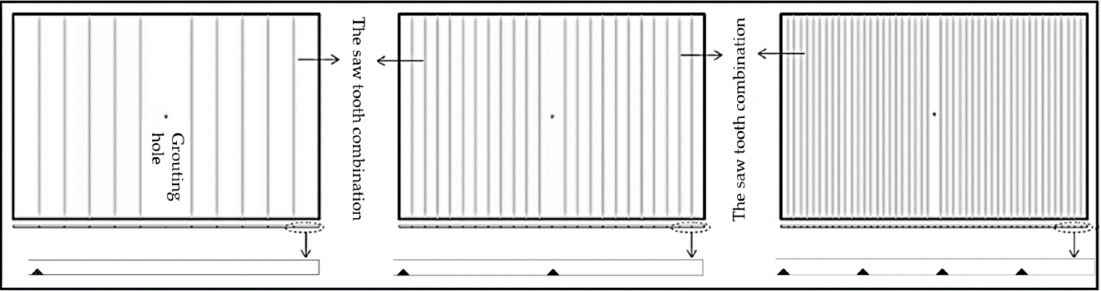
ff erent conditions of saw tooth Figure 9. Different conditions of saw tooth combinations. Figure 9. Di